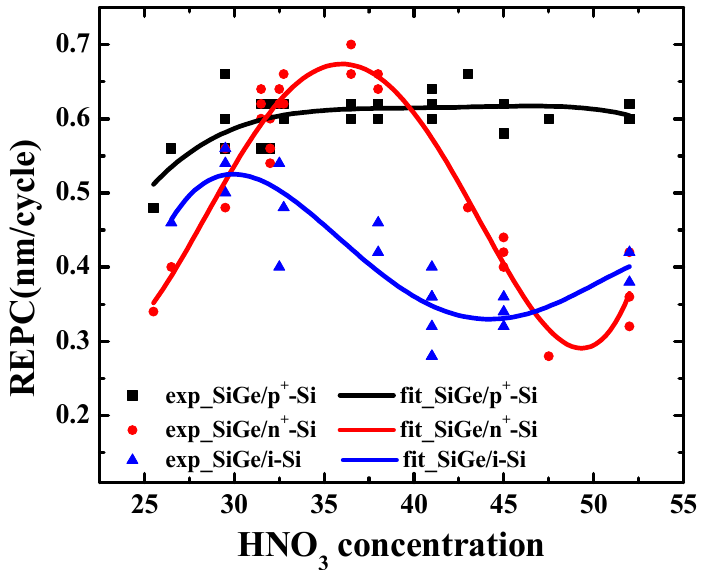
Figure 8. REPC of SiGe/n + -Si, SiGe/p + -Si, and SiGe/i-Si as a function of HNO 3 concentration. The dots in the figure are the experimental data, and the lines are the fitting curves of the experimental data. The slopes represent the relative etching amount per cycle (REPC) and the etching amount per cycle (EPC) of silicon.